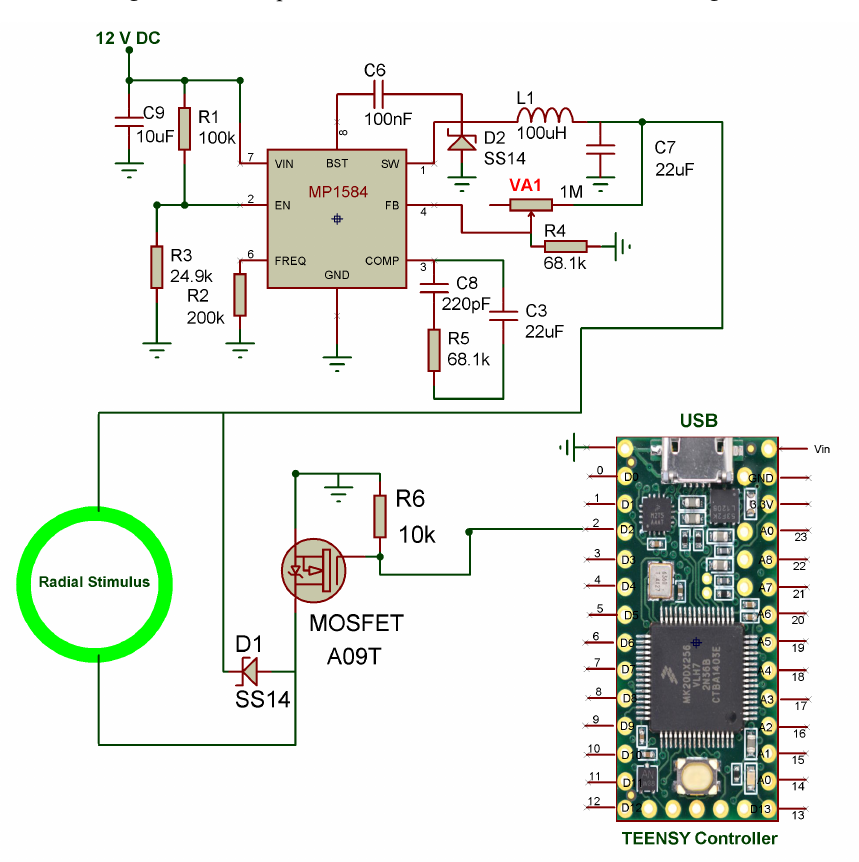
Figure 4. Visual stimulus generator circuit